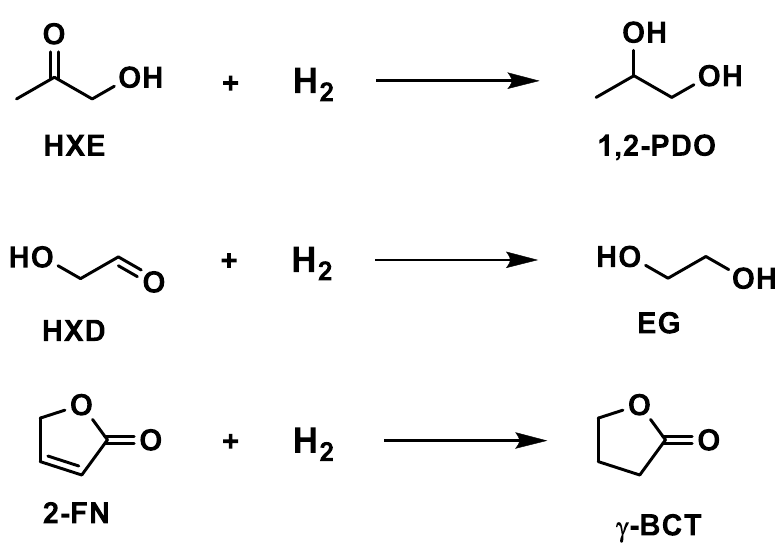
Figure 7. Hydrogenation of hydroxyacetone, hydroxyacetaldehyde, and 2-furanone.